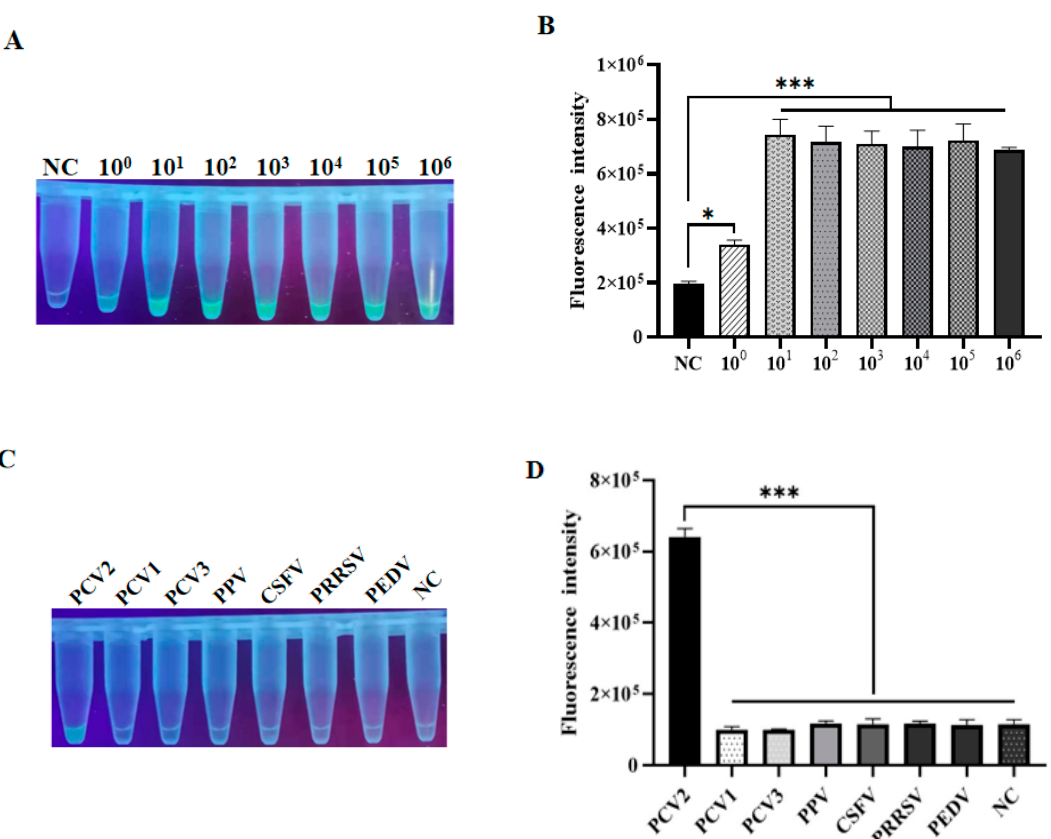
Figure 4. Fluorescence-based analysis of the sensitivity and specificity of LAMP-CRISPR. ( A ) Sensi- tivity of this method was determined by targeting various concentrations of pUCmT-rep plasmid. ( B ) The end-point fluorescent intensity was measured by ABI QuantStudio 5. ( C ) Visualization by UV light. ( D ) Florescence quantification after performing LAMP-CRISPR assay on DNA viruses individually including PCV1, PCV3, PPV, and PCV2, and RNA viruses like CSFV, PRRSV, and PEDV. NC: Negative control ( n = 3 technical replicates, value represents mean ± SEM, where *, *** represent p < 0. 05, < 0.001, respectively).